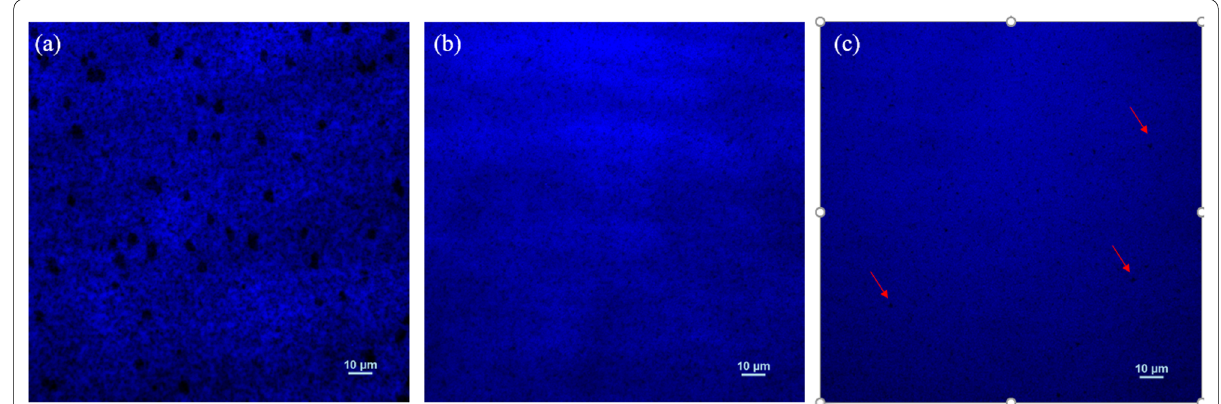
Fig. 6 The comparison of micro-PL results for sample A, B and C which corresponds to ( a ), ( b ) and ( c ), respectively. The red arrows indicate the non-radiative luminescence region with smaller size in sample